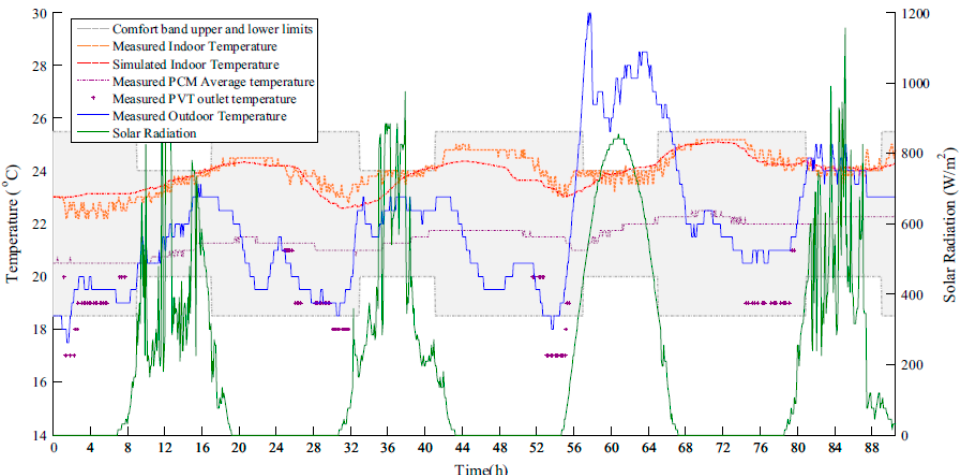
Figure 15. Temperature profile generated by the application of the hybrid MPC strategy in presence of available solar radiation in March 2015 [143].